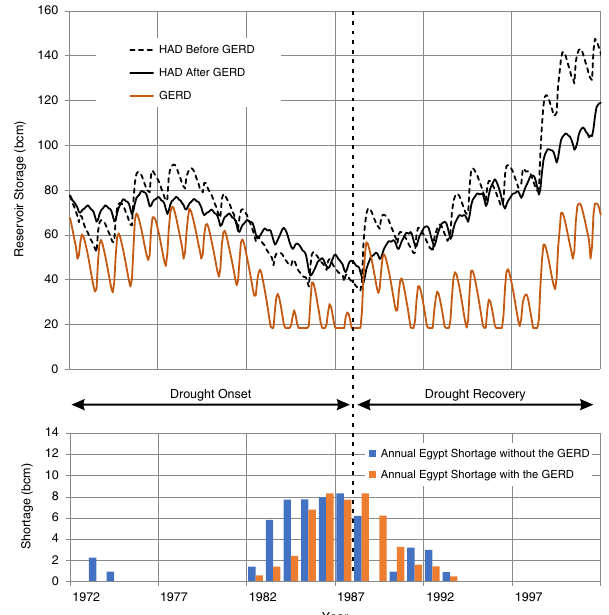
Fig. 7 Entering drought conditions from new normal operations under a historically dry 20-year sequence. Storage volumes for the GERD and HAD are shown above and shortages to Egyptian planned releases are shown